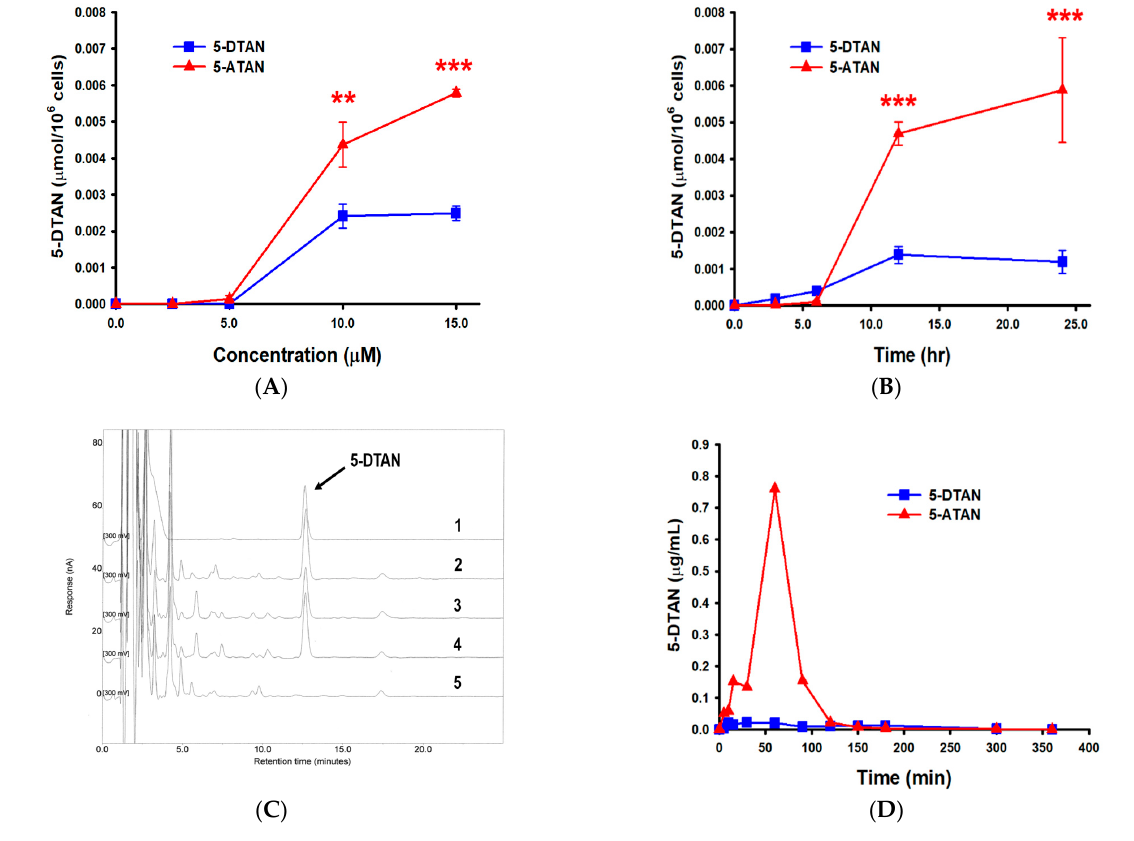
Figure 6. Cellular uptake and oral bioavailability of 5-DTAN. ( A ) Cytosolic concentrations of 5-DTAN in PC-3 cells treated with various concentrations of 5-DTAN or 5-ATAN for 12 h, ( B ) with 15 µM of 5-DTAN or 5-ATAN for different time periods. Data are expressed as means ± SD ( n = 3). ** p < 0.01 and *** p < 0.001 compared with 5-DTAN-treated group. ( C ) Representative HPLC chromatograms of standard stock (1), plasma after administration of 5-ATAN (2–4), and blank plasma (5). ( D ) Mean plasma concentration-time curves of 5-DTAN after oral administration of 50 mg/kg of 5-DTAN or 5-ATAN to C57BL/6J mice. Table 2. Pharmacokinetic parameters of 5-DTAN in plasma of C57BL/6J mice following an oral single dose of 50 mg/kg of 5-DTAN or